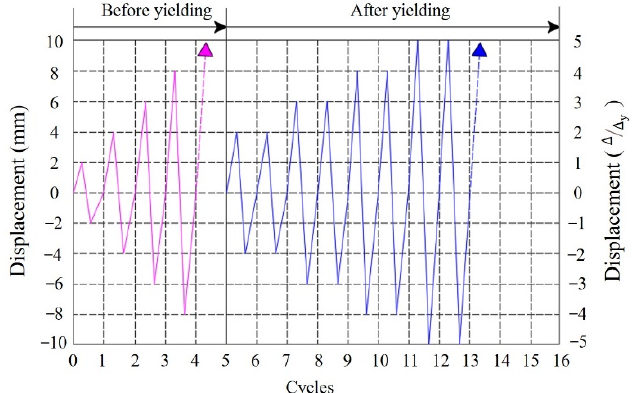
Figure 5. Loading procedure in the test.